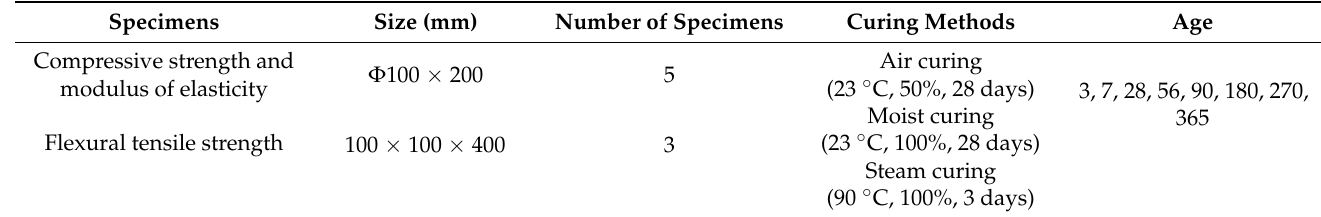
Table 2. Variables for experiments and curing